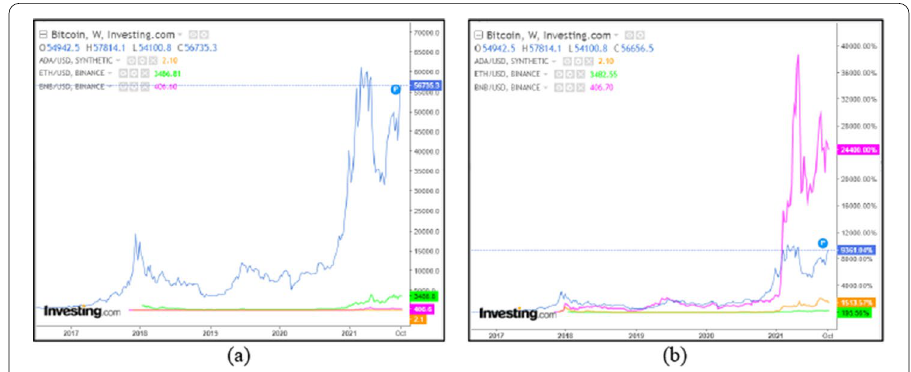
Fig. 1 Cryptocurrencies’ price fluctuation ( a ) and growth percentages ( b ) in the last few years